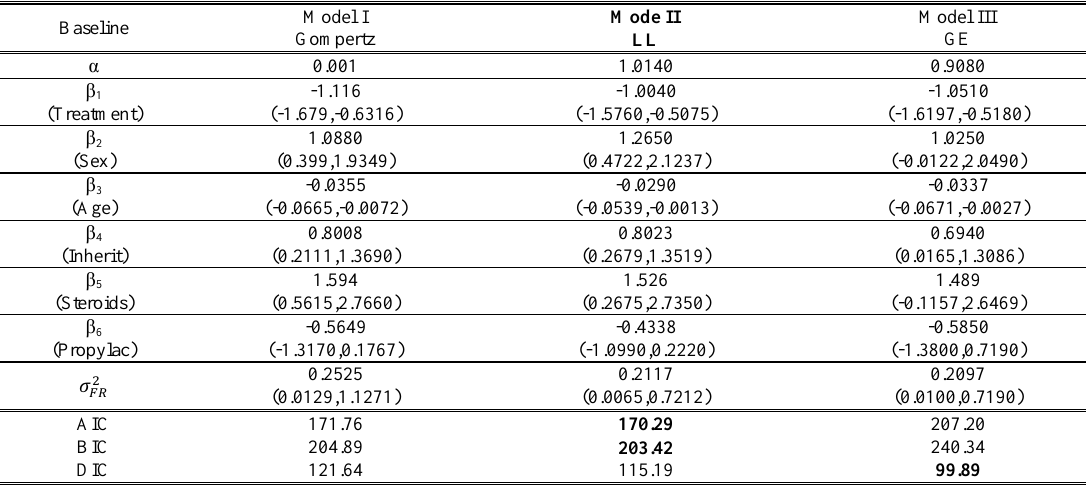
Table 3. Parameter estimates (credible intervals) of CGD dataset under the generalized gamma shared frailty model